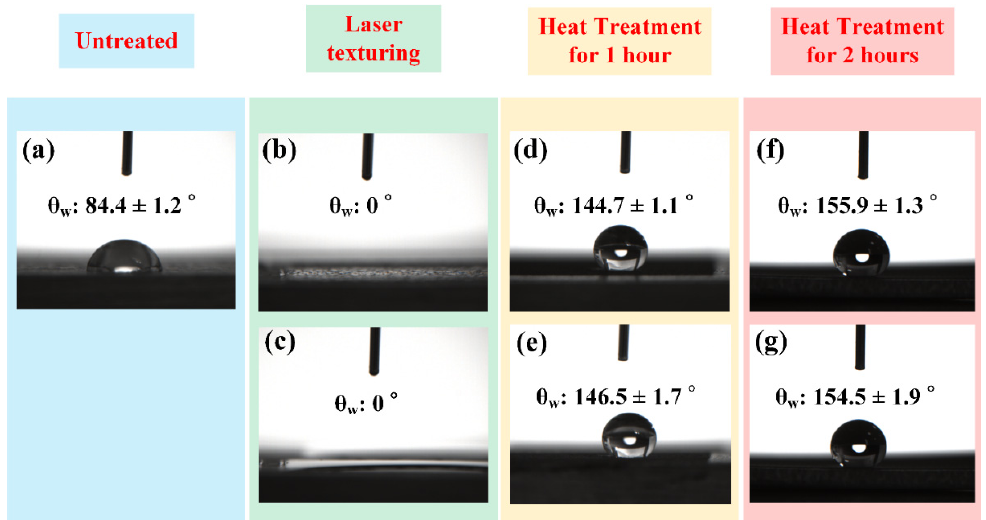
Figure 6. Contact angle measurement results for ( a ) untreated BMG surface; ( b ) laser textured BMG surface using the power of 10.5 W, the repetition rate of 30 kHz, the scanning speed of 60 mm/s, and a unidirectional surface pattern; ( c ) laser textured BMG surface using the power of 12 W, the repetition rate of 30 kHz, the scanning speed of 40 mm/s, and a cross-hatch surface pattern; ( d , e ) laser textured BMG surfaces in ( b , c ) after heat treatment for 1 h; ( f , g ) laser textured BMG surfaces in ( b , c ) after heat treatment for 2 h.